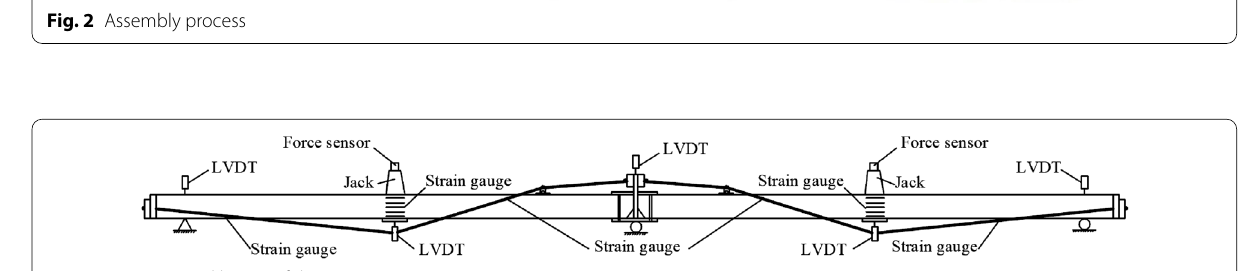
Fig.3 Test setup and layout of the strain gauges